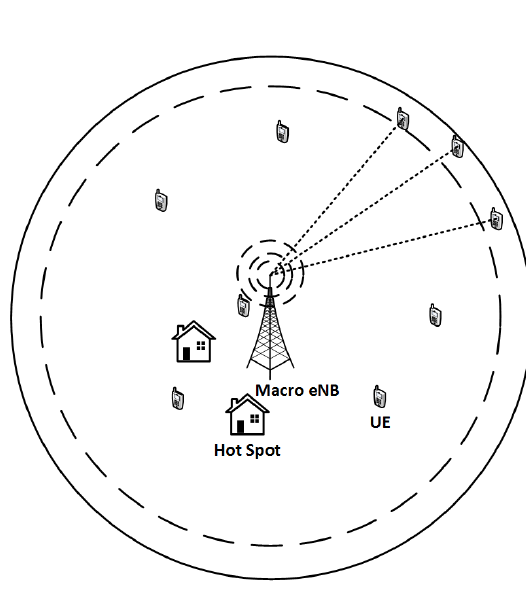
Figure 3. Power Enhancement Scenario Figure 4. Femto Relay